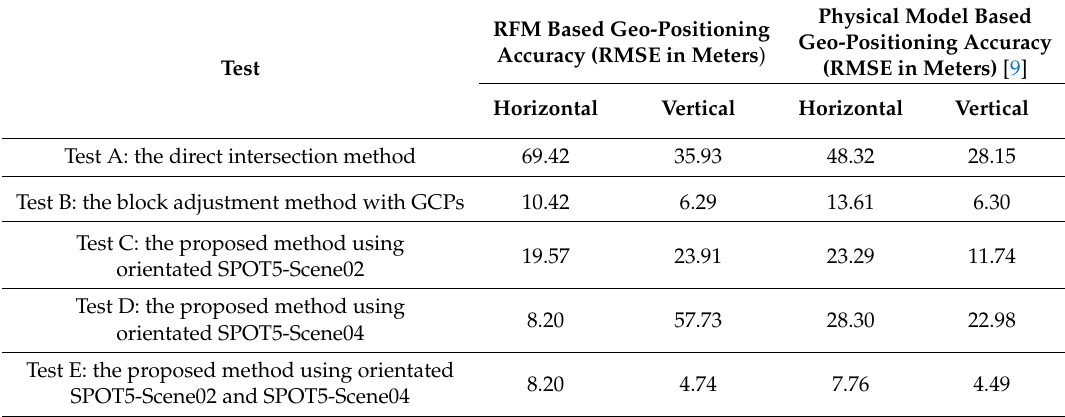
Table 3. Accuracies for SPOT5-Scene01 and SPOT5-Scene03 using the RFM based methods and the physical model based